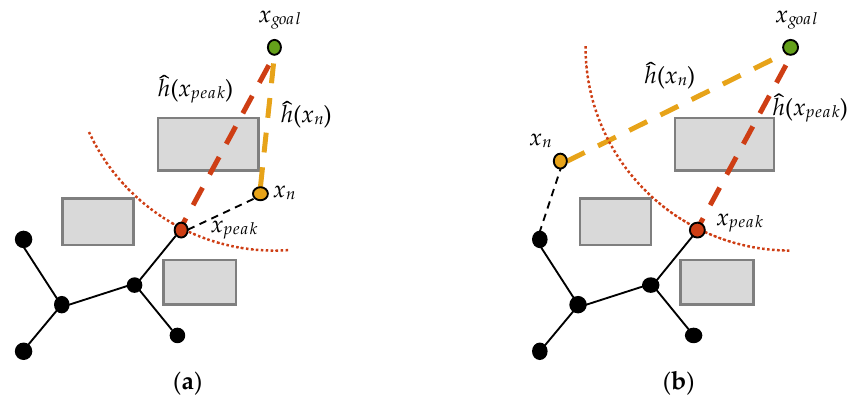
Figure 4. Tree construction of case ( a ) and case ( b ).